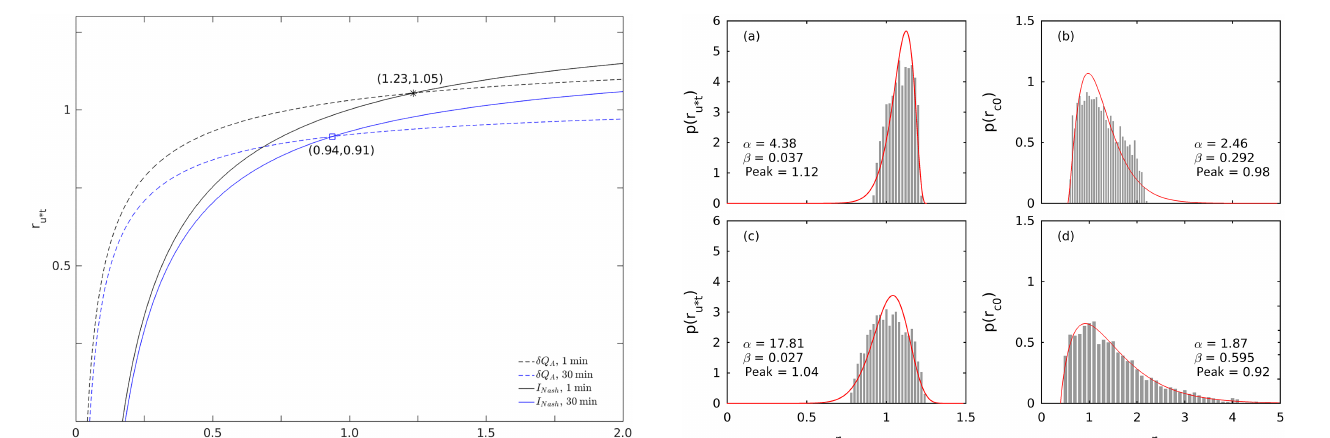
Figure 8. δQ A and I Nash are both functions of r c the dashed curves, the condition δQ A = min is satisfied and along the solid curves the condition I Nash = max is satisfied. The curves are estimated with both Q 1min and Q 30min .